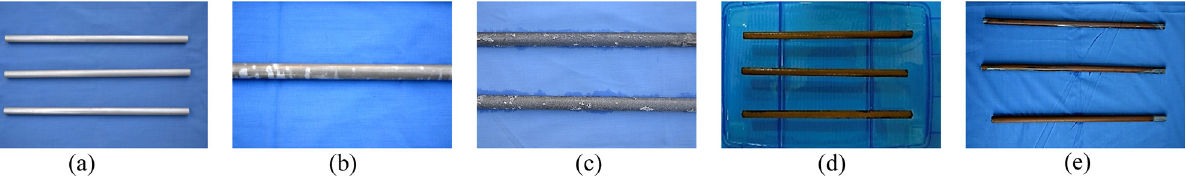
Figure 6: Surface state of the specimens after immersion for 192 h: ( a ) 2#, ( b ) 4#, ( c ) 6#, ( d ) 8#, and ( e )